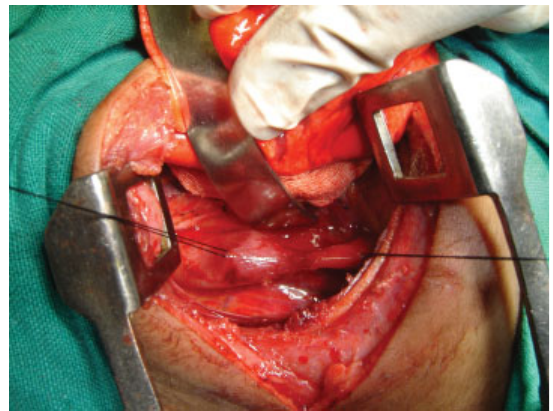
Fig. 2 Operative photograph showing dilated upper pouch, in-con- tinuity with the thickened lower pouch. No fi stula is noted.